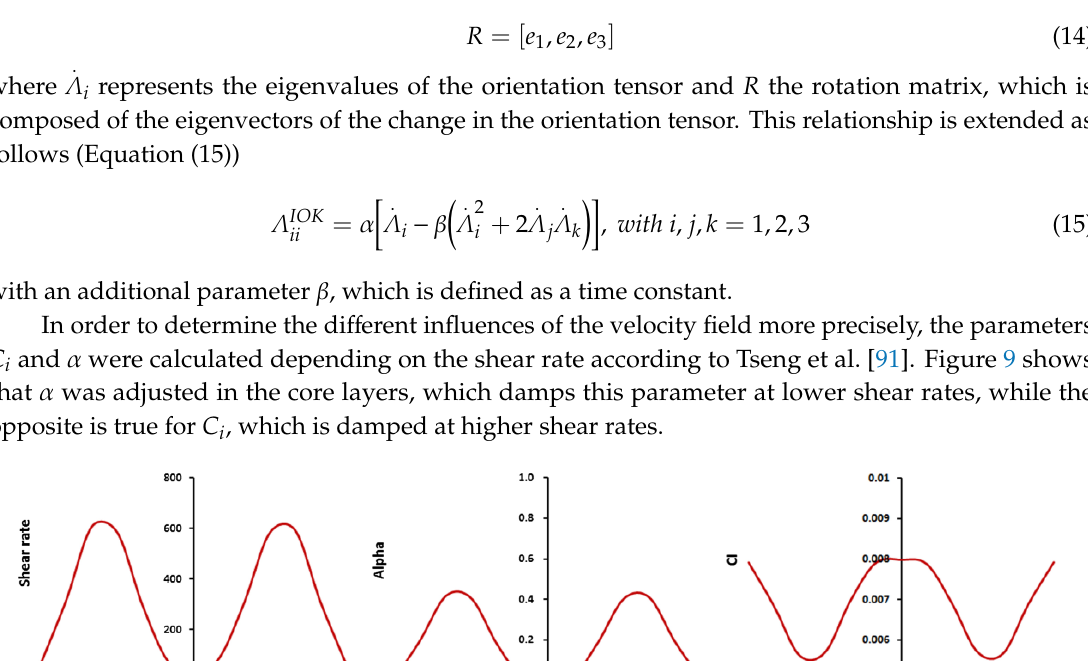
Figure 9. Shear rate-dependent adaption of the parameters 𝐶 𝑖 and 𝛼 [91]